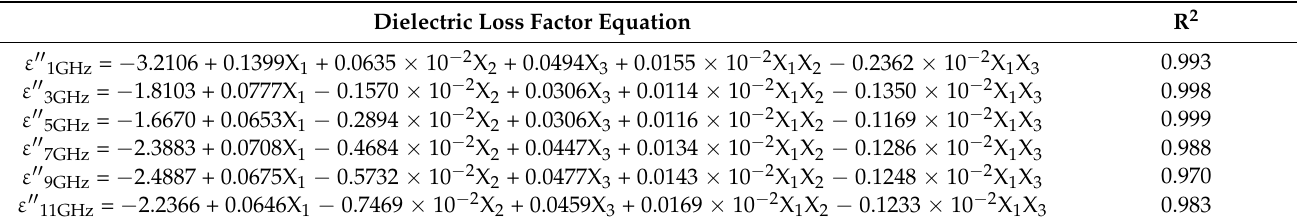
Table 2. Regression equations for the dielectric loss factor ( ε (cid:48)(cid:48) ) of the porous nHA/S composites at 1, 3, 5, 7, 9, and 11